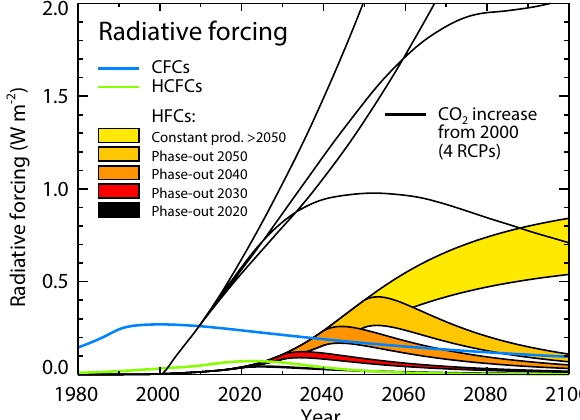
Fig. 4. Radiative forcing of halocarbons for the period 1980 to 2100 and increase in CO 2 radiative forcing from 2000. The radia- tive forcings of halocarbons are shown for the baseline scenarios of the CFCs and HCFCs from WMO (2011) and the upper and lower ranges of the HFC scenarios from Velders et al. (2009). In these sce- narios the HFC production past 2050 is constant at the 2050 level. Four additional scenarios are shown in which there is a global pro- duction phaseout of HFCs in 2020, 2030, 2040, or 2050, as in Fig. 2. No bank destruction is assumed. For CO 2 the radiative increases rel- ative to 2000 are shown for the four RCP scenarios (Meinshausen et al., 2011). The radiative forcing values for the halocarbons rep- resent net changes from the start of the industrial era (ca. 1750) to